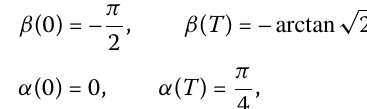
Figure 4 Spatial non-adiabatic superposition scheme | 1 (cid:2) → 1 √ approximation. T / τ = 400. Sub-figures are the same as in Figure 2 and the fidelity shown in (b) is defined as F = |(cid:10) Ψ target | Ψ ( t ) (cid:5)| 2